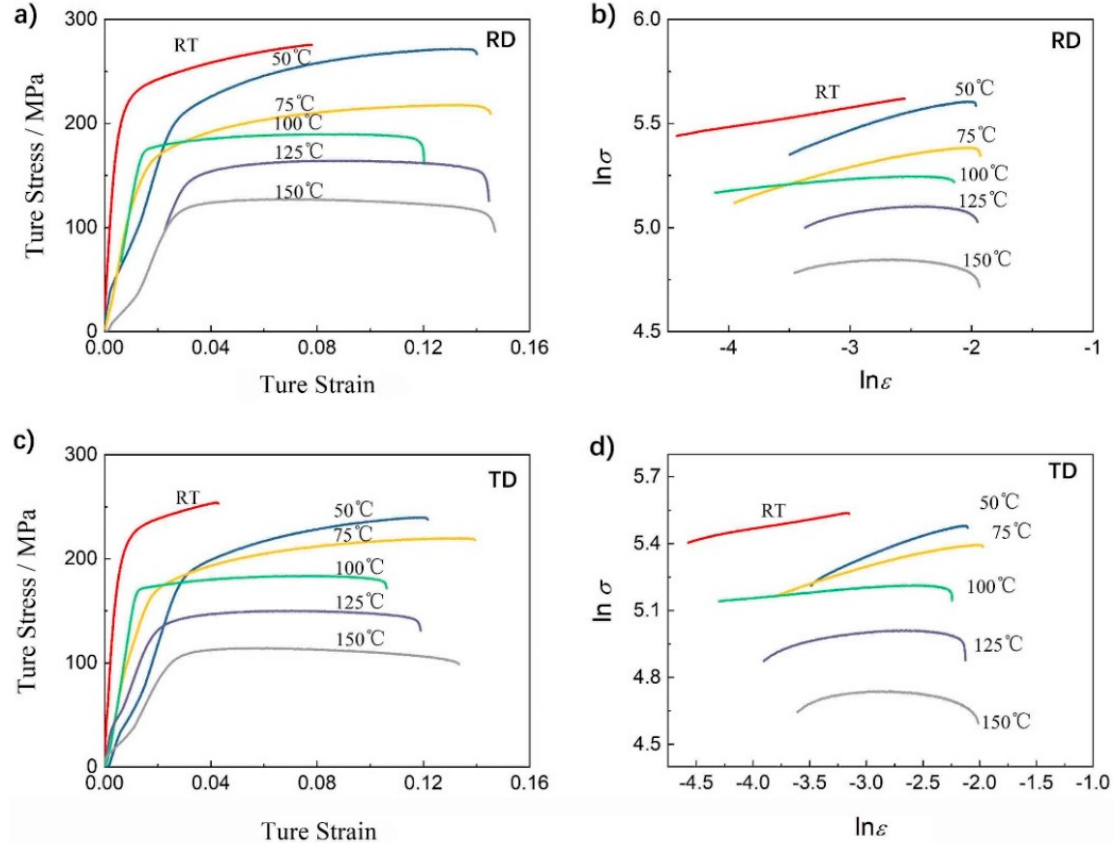
Figure 5. Work hardening exponent extraction. ( a , c ) are the true σ vs. ε data for the tensile tests along RD and TD, respectively. ( b , d ) are the ln σ vs. ln ε curves for work hardening exponent extraction based on ( a ) and ( c ), respectively.